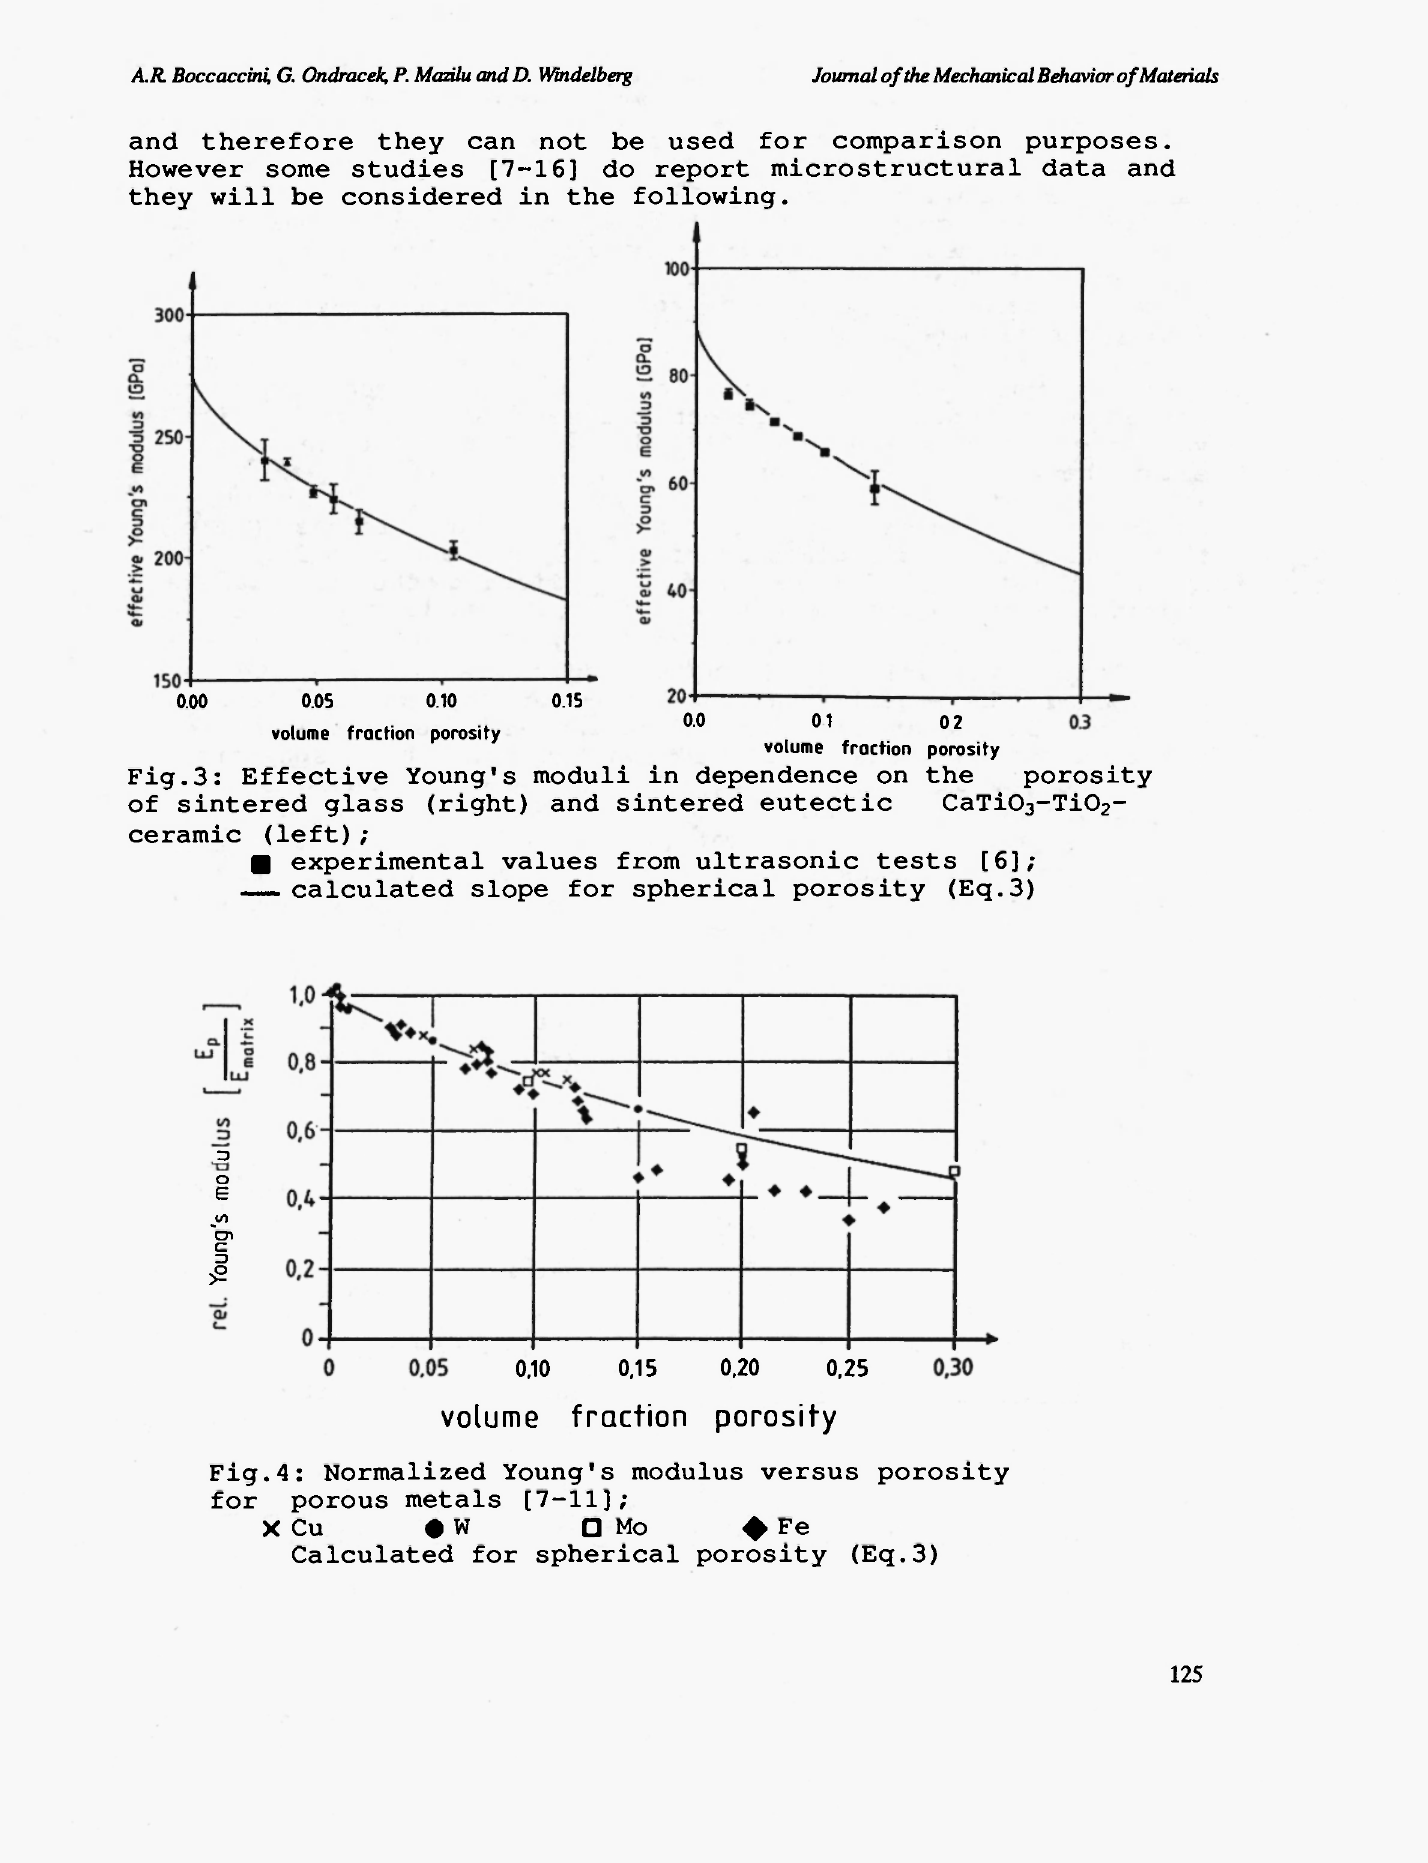
Fig.4: Normalized Young's modulus versus porosity for porous